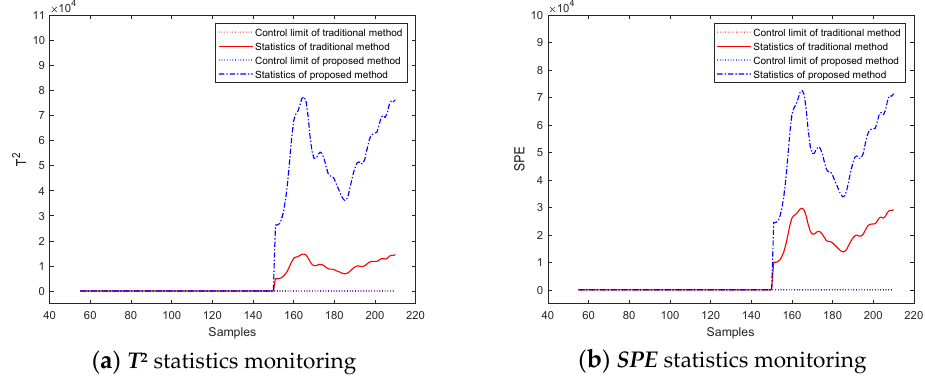
Figure 19. Multi-mode online monitoring of sensor fault.